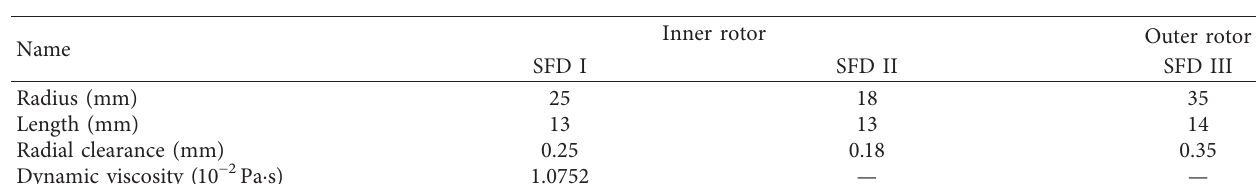
Table 7: Parameters of